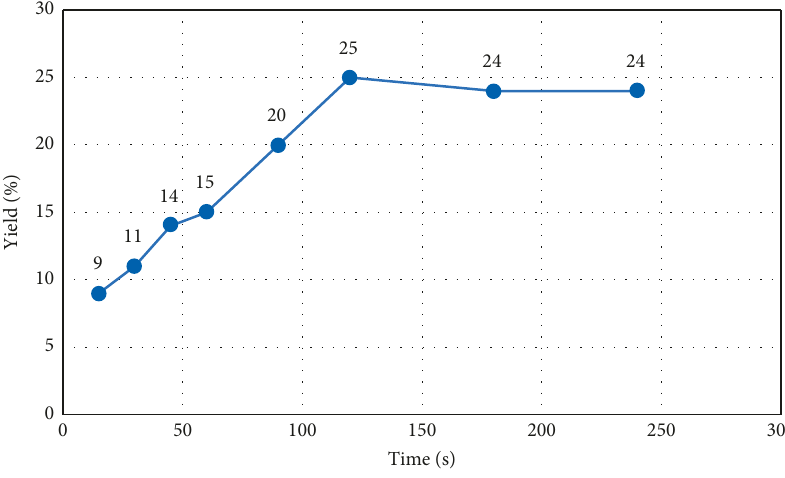
Figure 1: Optimization of the extractability of the CSLE,